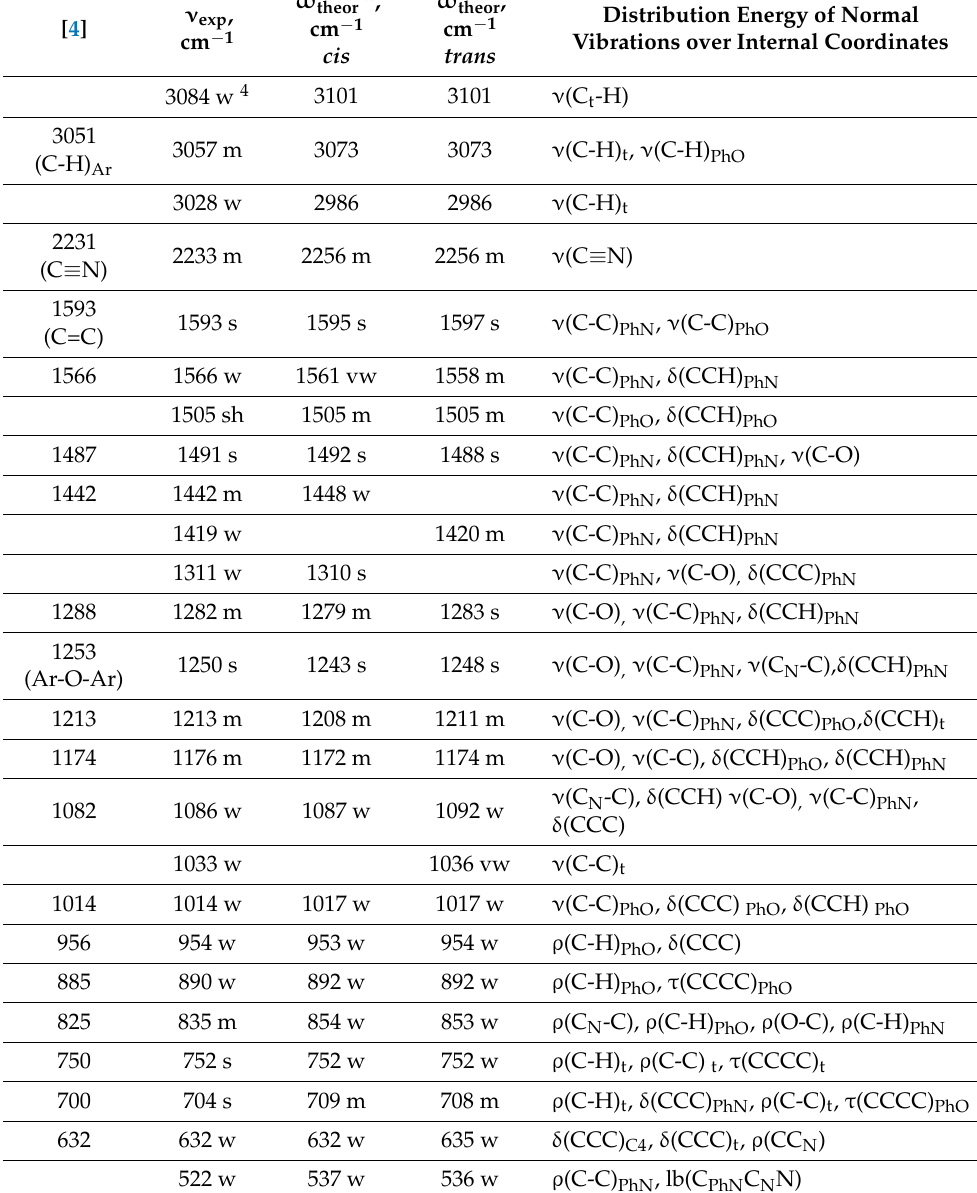
Table 2. Experimental ( ν exp ) and theoretical ( ω theor ) vibrational frequencies for cis - and trans